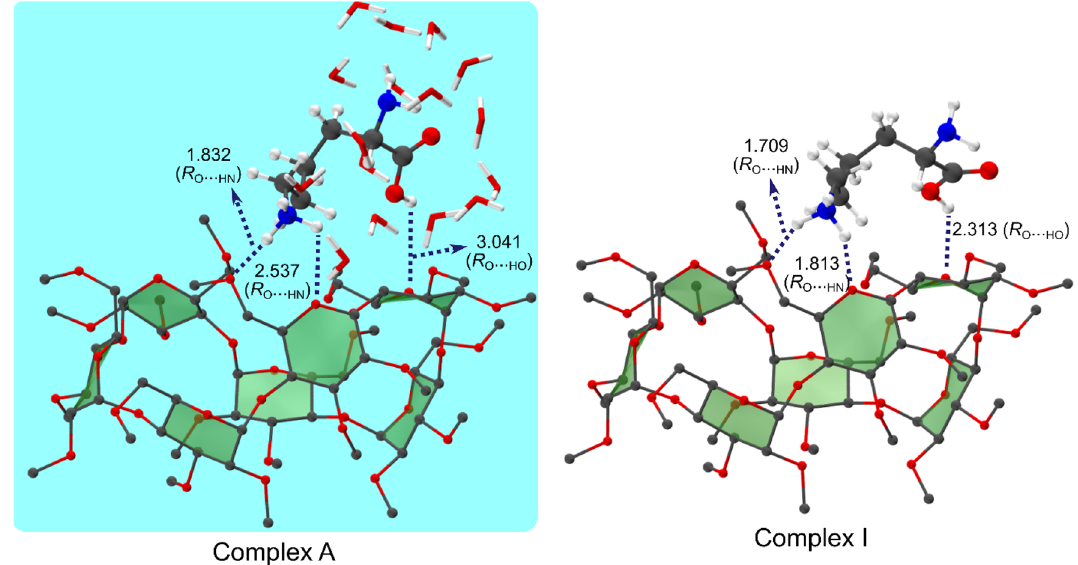
Figure 4. Comparison of perm-CD–LysH + configurations in solution (Complex A, wB97X-D/6-31G*) and in gas phase (Complex I,